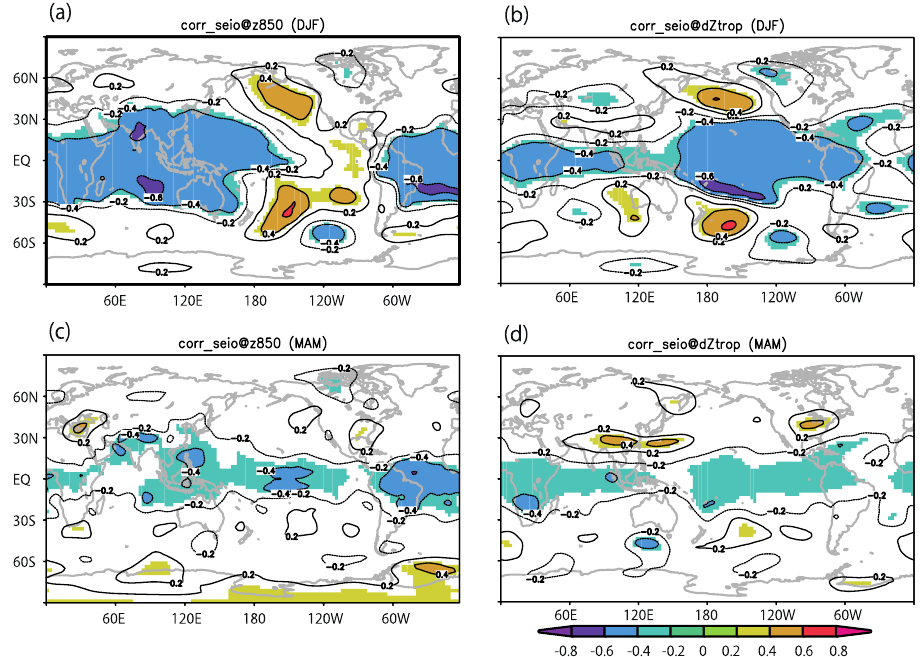
Figure 6. Same as Figure 5 but for the TCF anomaly (defined as occurrence in 5° × 5° bins, units are TCs per season) over the SEIO region (averaged over 10 – 30° S, 90 – 120° E). ( a ) DJF z850, ( b ) DJF z200-z850, ( c ) MAM z850, ( d ) MAM z200-z850.